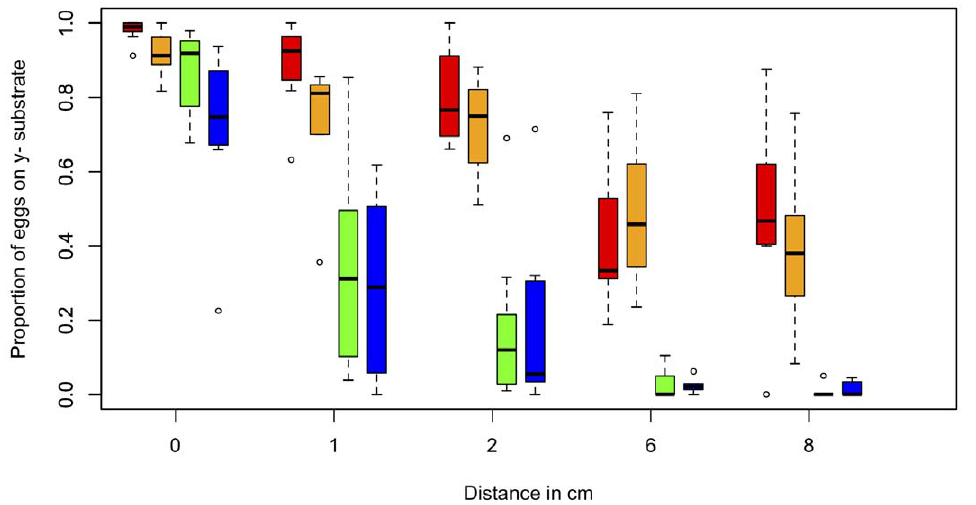
Figure 6. The effect of distance on oviposition preference. A Tukey box plot is shown for each genotype * distance combination; red = RAL- 555, orange = RAL-437, green = RAL-208, blue = RAL-365.